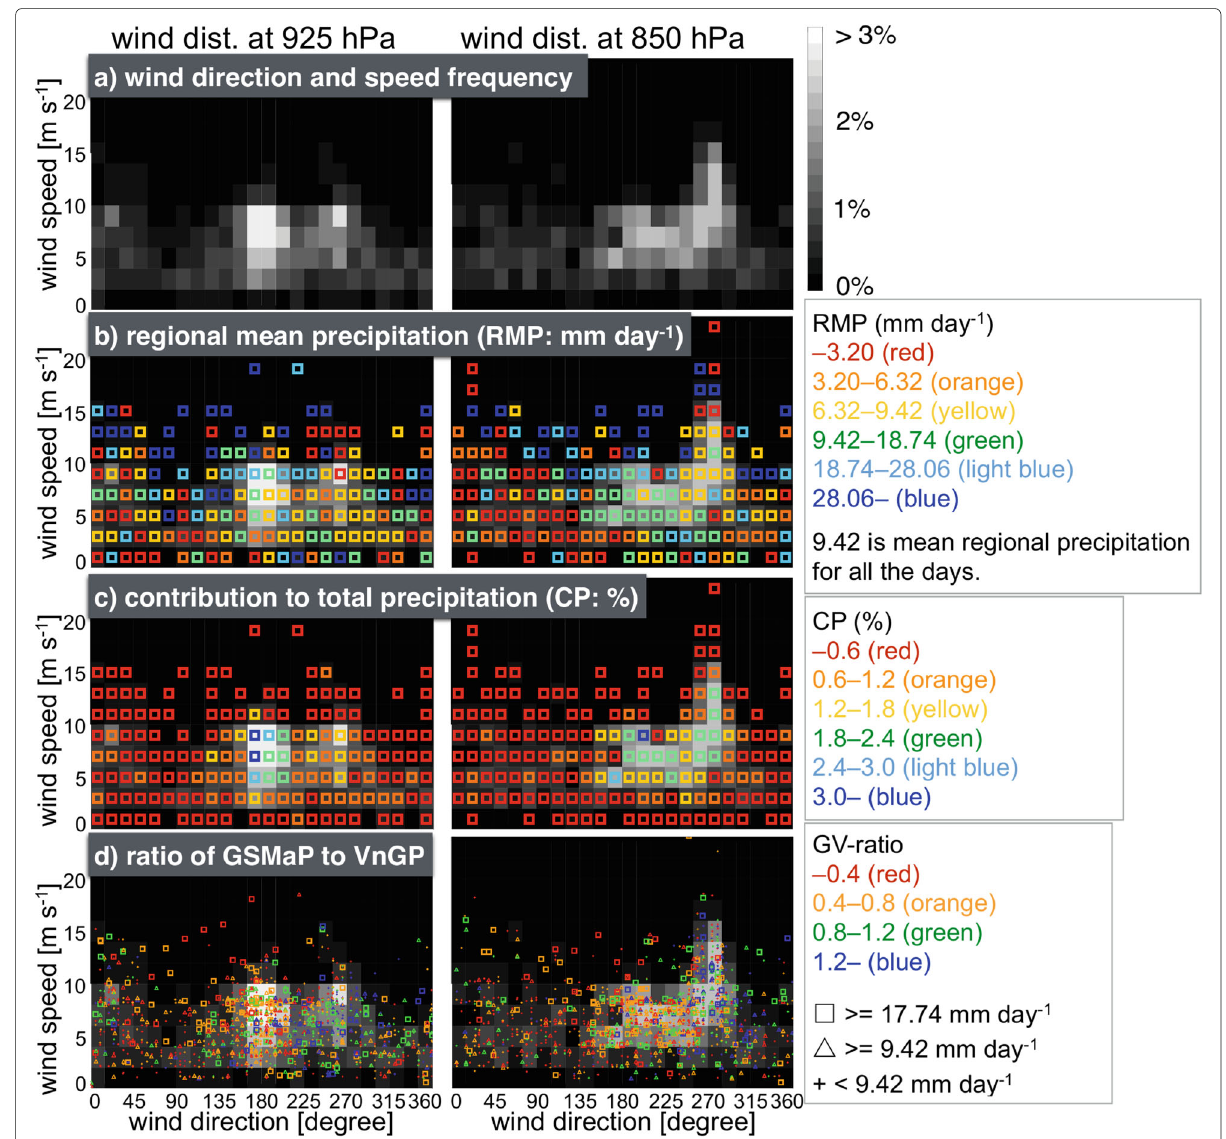
Fig. 4 Frequency distribution of wind direction and speed and related features, in precipitation, for May–Aug., from 2001 to 2010. a Hanoi morning (00Z) wind direction and speed frequency distribution (frequency is defined as the ratio to the number of all observations). b Regional mean precipitation (RMP) over the area in Fig. 1a averaged for the days with winds corresponding to the wind direction and speed bins superposed on panel a . c Contribution of the precipitation (CP) accumulated over the same days as in panel b to the total. d The ratio of the RMP averaged over the same days and regions as in panel b , in the GSMaP, to that in the VnGP (GV ratio). The left and right columns illustrate the wind at 925 and 850 hPa levels, respectively